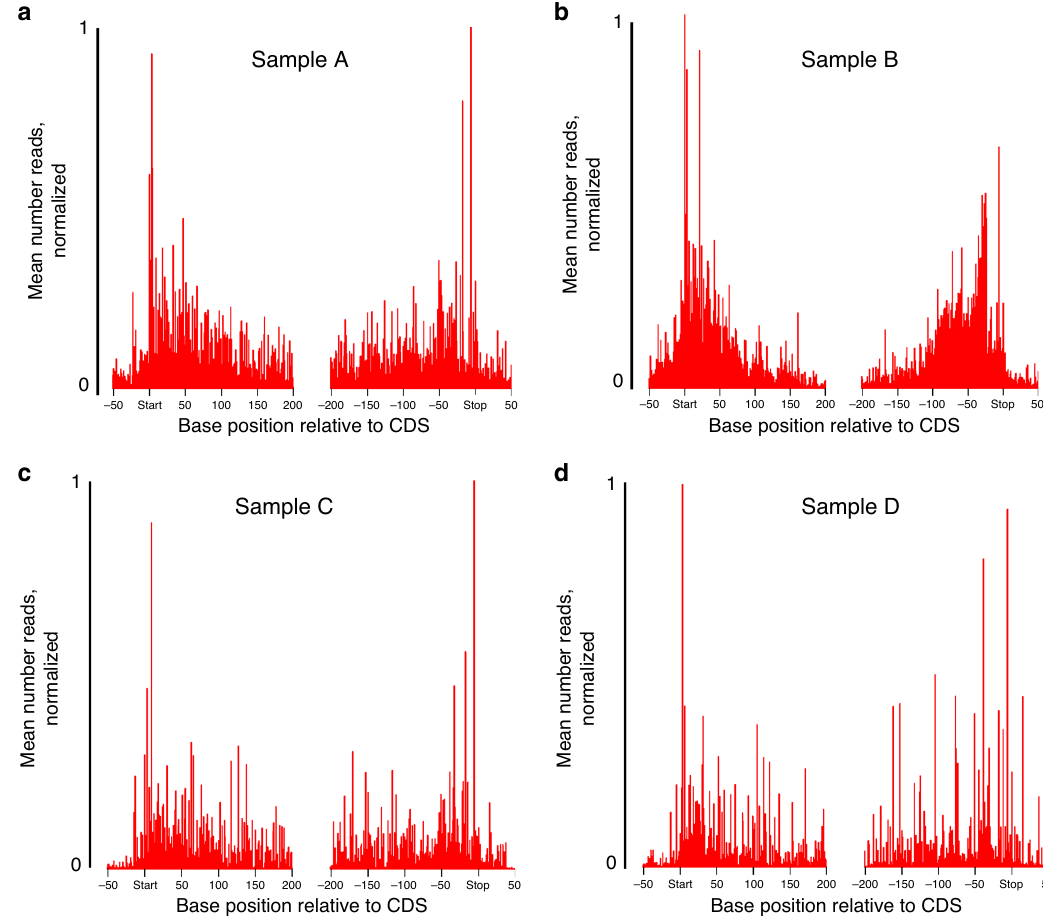
Fig. 4 MetaRibo-Seq signal in fecal samples shows expected characteristics of ribosome pro fi ling. a – d Average MetaRibo-Seq signal across genes and fl anking regions for Samples A − D, respectively. Every predicted open reading frame containing at least ten reads is included in the analysis. Replicates reads are combined and treated as a single read for this